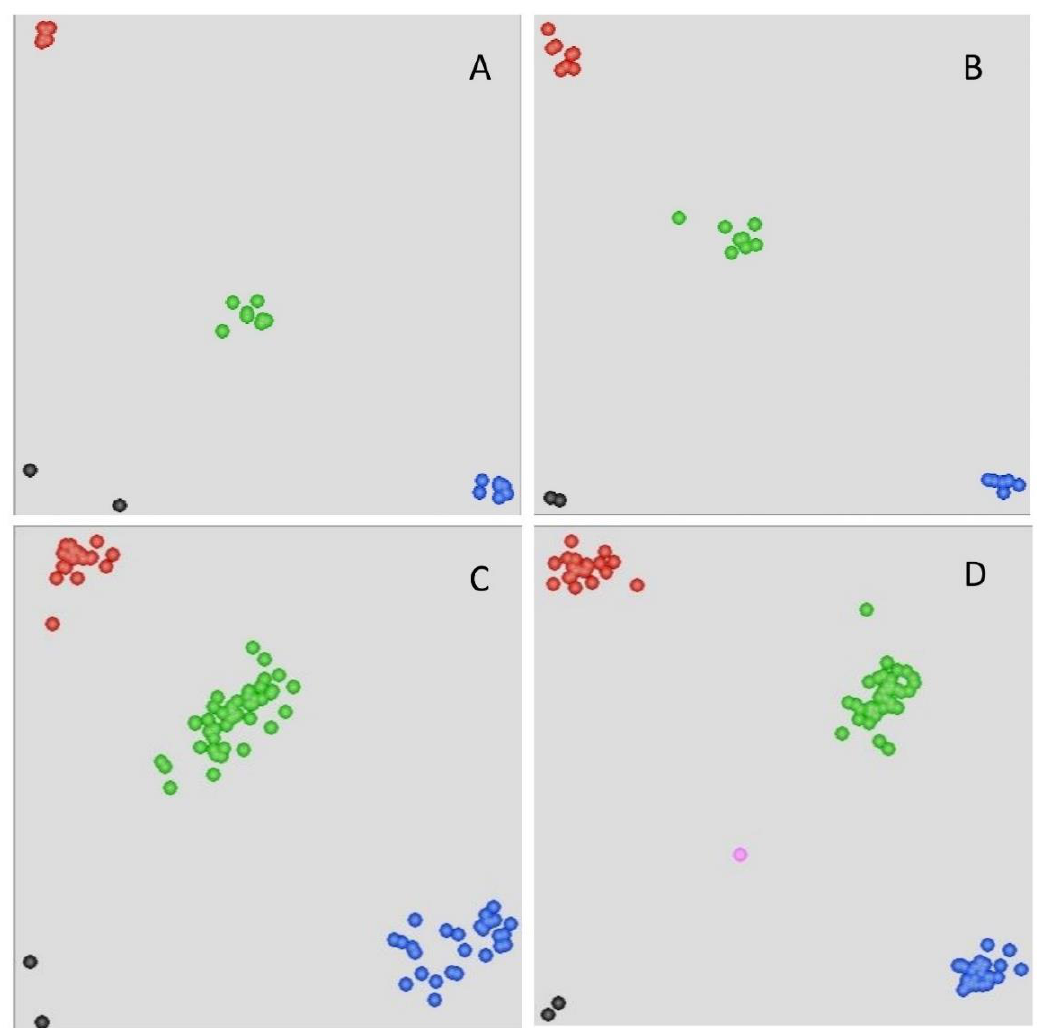
Figure 1. Genotypic plots from selected Kompetitive allele-specific polymerase chain reaction (KASP) assays. The results of the parents and small population using markers ( A ) BS00084417_51 and ( B ) AX-111128667. Results of the F 2 population using markers ( C ) RFL_Contig4423_529 and ( D ) AX-95682571. The central cluster (green) comprises heterozygous individuals, whereas the clusters near the axes are homozygous for either LF2099 (red) or Chinese Spring (blue). The black dots represent the nontemplate control, and the pink dots represent missing or failed data.